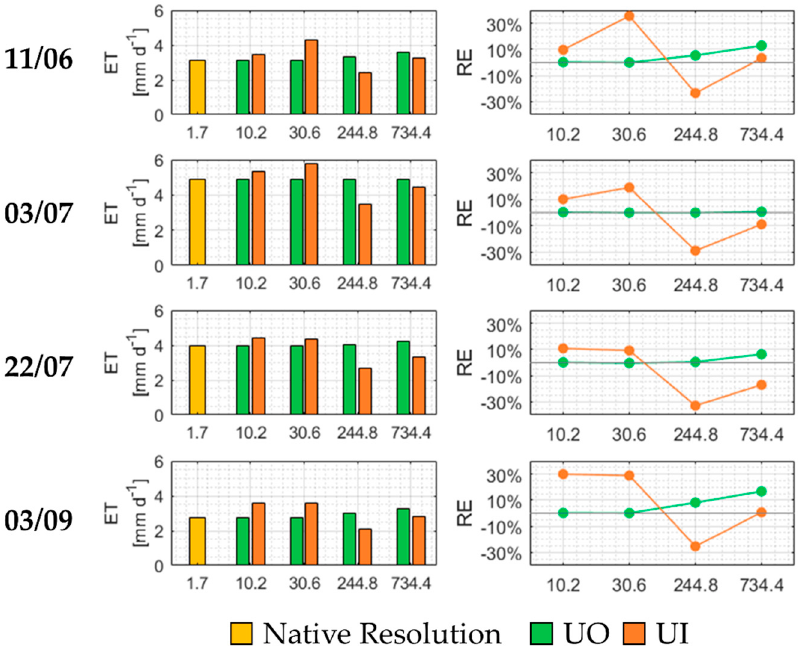
Figure 11. Average daily ET of the main experimental area for some of the test days. In the left-hand column, absolute-value comparisons between the upscaling approaches and the native-resolution value. In the right-hand column, Relative Errors (RE) with respect to the highest-resolution ET.